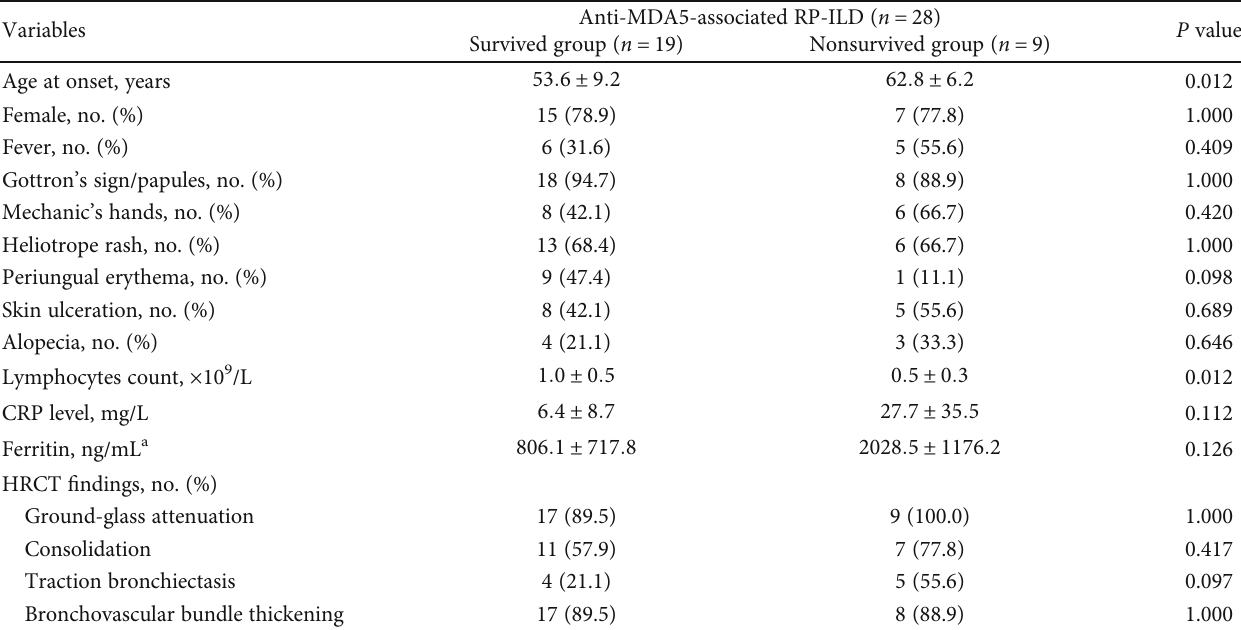
Table 3: Comparison of clinical and laboratory characteristics between survived and nonsurvived patients with anti-MDA5-associated RP- ILD.